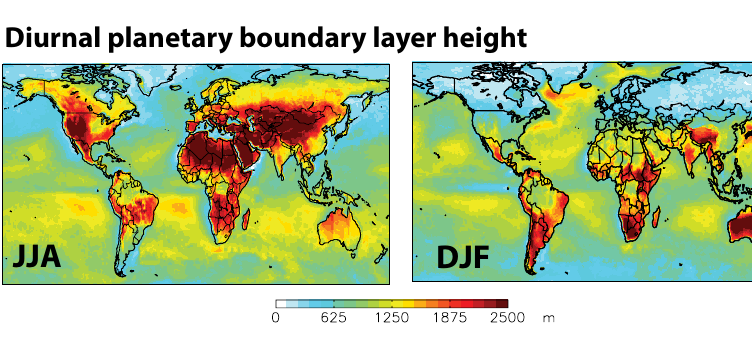
Figure 11. Percentage of total column biomass burning emissions injected into the PBL and into the FT (above PBL + 500 m to 6 km and above 2 km to 6 km) in each grid cell based on the estimated AOD-weighted injection heights ( a ) and global diurnal planetary boundary layer height from MERRA-2 ( b ). Hourly PBL heights were average from 10:00 a.m. to 1:00 p.m. (LT) to represent the MISR overpass time over the regions. Results are shown for northern summer (JJA) and winter